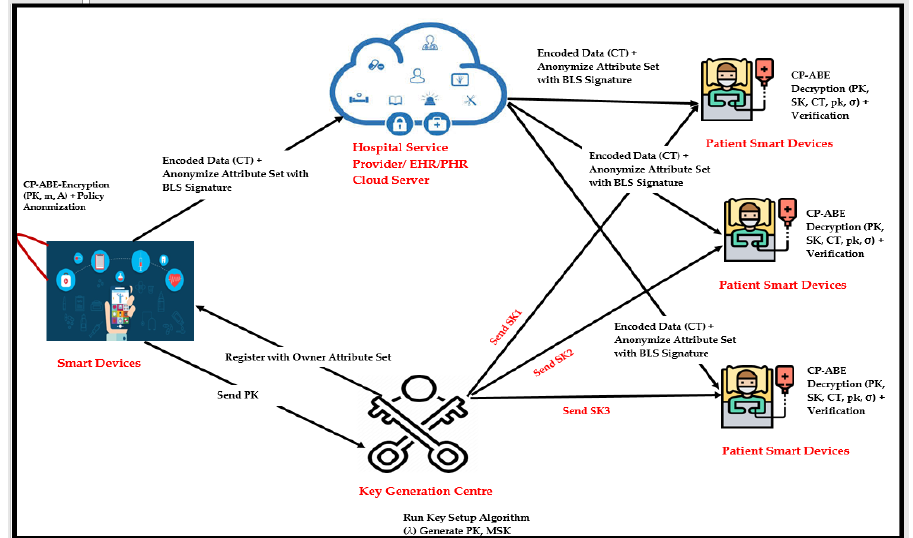
Figure 6. An application scenario for the proposed